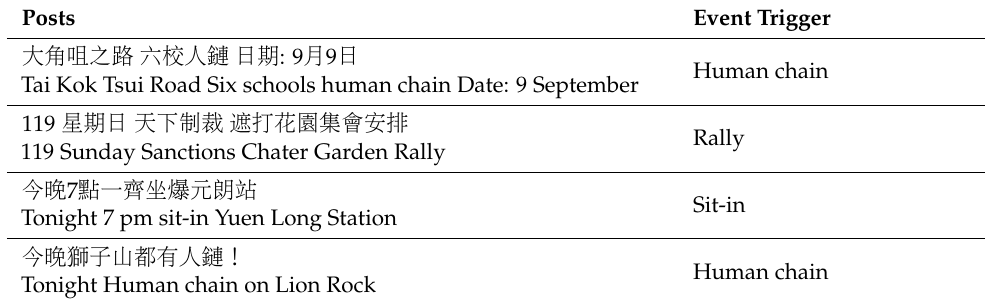
Table 6. Event extraction of the newly collected data.